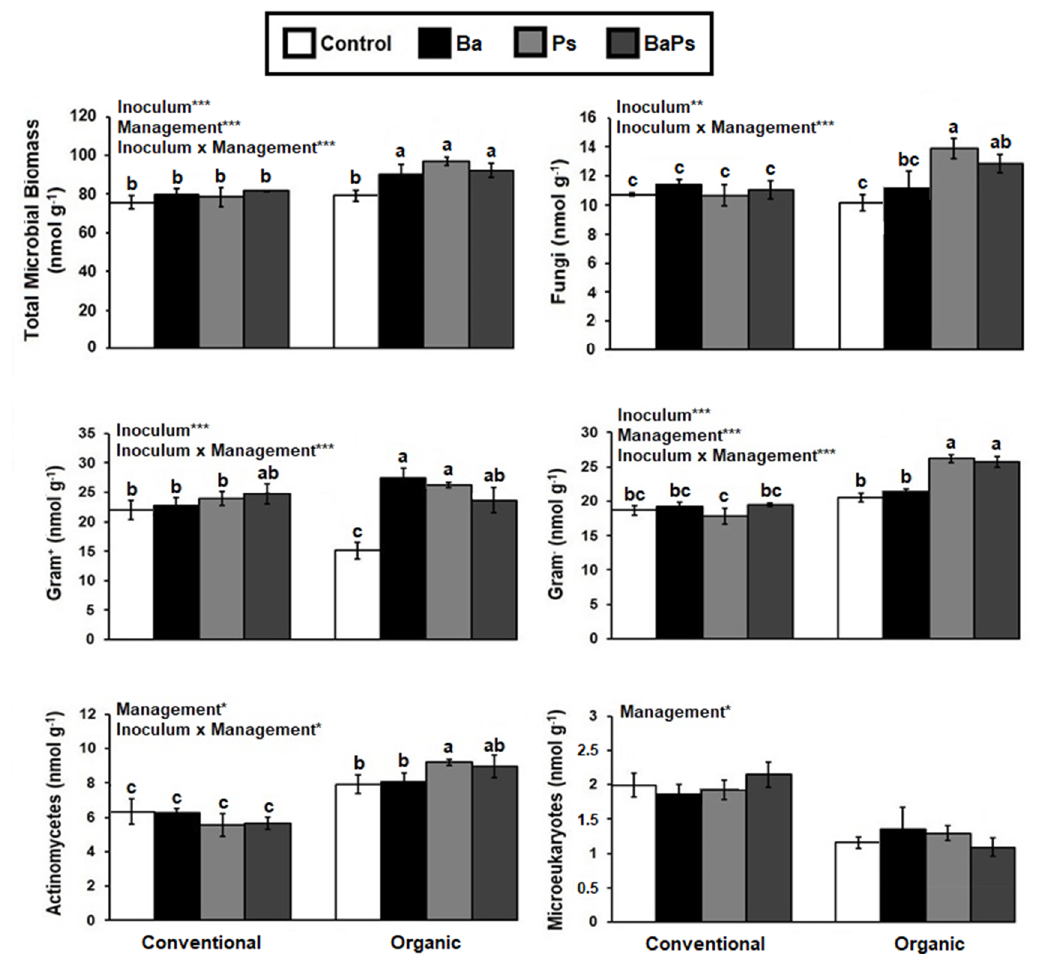
Figure 2. Mean biomass ( ± SE) of total microbes, fungi, Gram + and Gram − bacteria, actinomycetes, and microeukaryotes in the conventionally and organically managed systems, at the four treatments. “Inoculum”, “Management”, and “Inoculum × Management” at the top of the graphs, indicate a significant e ff ect of these factors and their interaction, respectively, as revealed by two-way ANOVA (*: p < 0.05, **: p < 0.01, ***: p < 0.001, for all cases n = 4). The di ff erent letters above bars represent statistically significant di ff erences between treatments described by the inoculum type × management system as emerged from Fisher’s test (Fisher post hoc; a: Corresponds to the highest value).